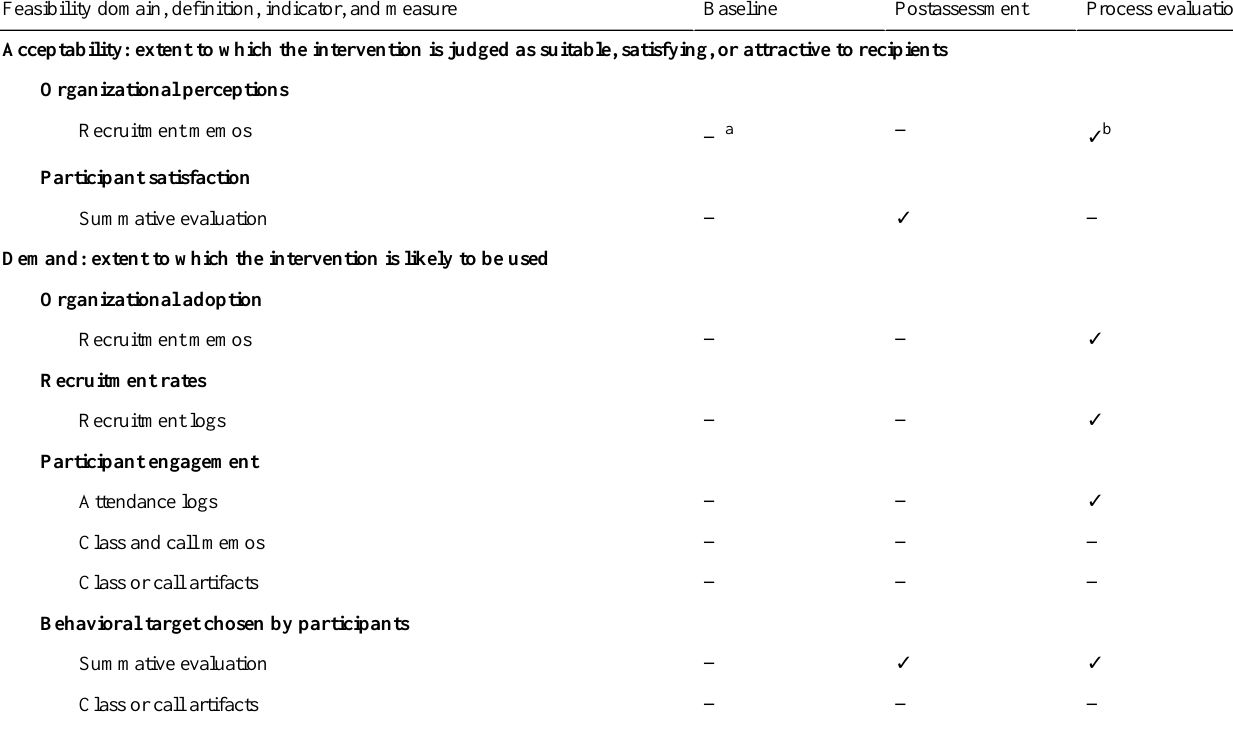
Table 1. Summary of measures used in the feasibility trial of we Survive. Acceptability: extent to which the intervention is judged as suitable, satisfying, or attractive to recipients Organizational perceptions